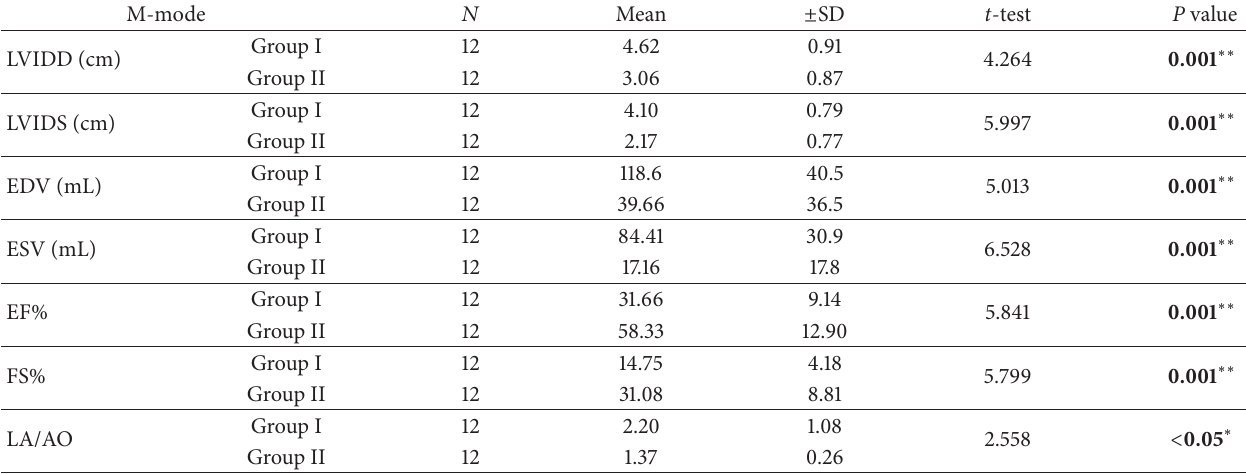
Table 4: M-mode echocardiographic data of group I compared to group II.